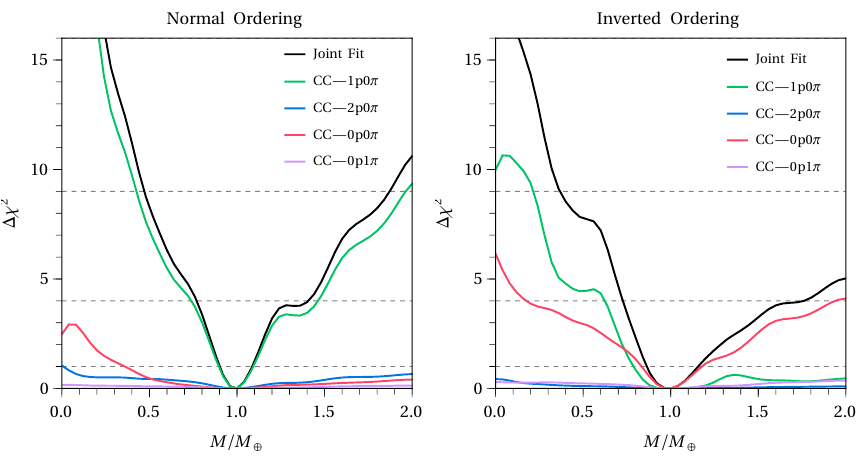
Figure 12 . DUNE’s 400 kton-year sensitivity to the total mass of the Earth (assuming the shape of the matter density profile is known) for several different charged current (CC) event topologies accounting for different number of protons and pions (colored lines as indicated) and their combination (black line) for normal (left panel) and inverted (right panel) neutrino mass ordering.